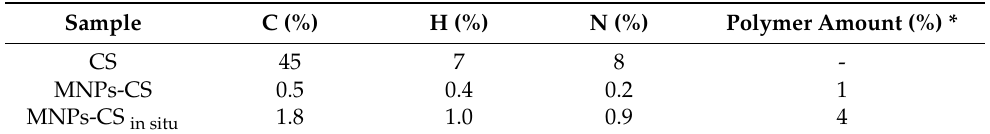
Table 1. Elemental analysis of uncoated MnFe 2 O 4 (MNPs), CS-coated MNPs (MNPs-CS and MNPs-CS in situ samples), and CS.